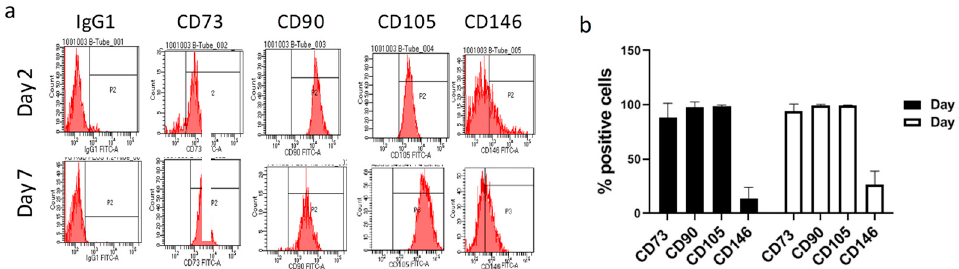
Figure 1. Flow cytometry analysis of IgG1 (isotype negative control), CD73, CD90, CD105, and CD146 markers ( a ). Quantitative analysis of hASCs embedded in VG-RGD hydrogel at days 2 and 7 ( b ). Data are expressed as percentage of positive cells. Data presented as mean ± SD, n = 5.